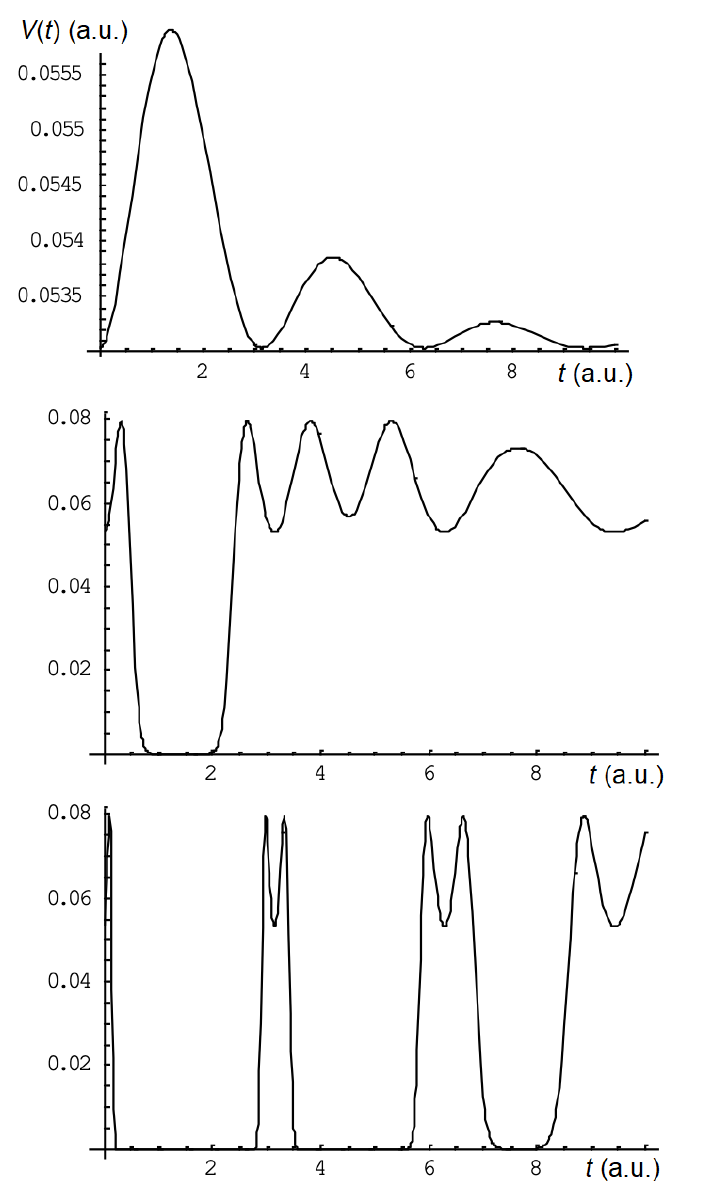
Figure 1. The output signal obtained by numerical simulation for small ( α = 10), medium ( α = 200), and large ( α = 10,000) elongation (scales in arbitrary